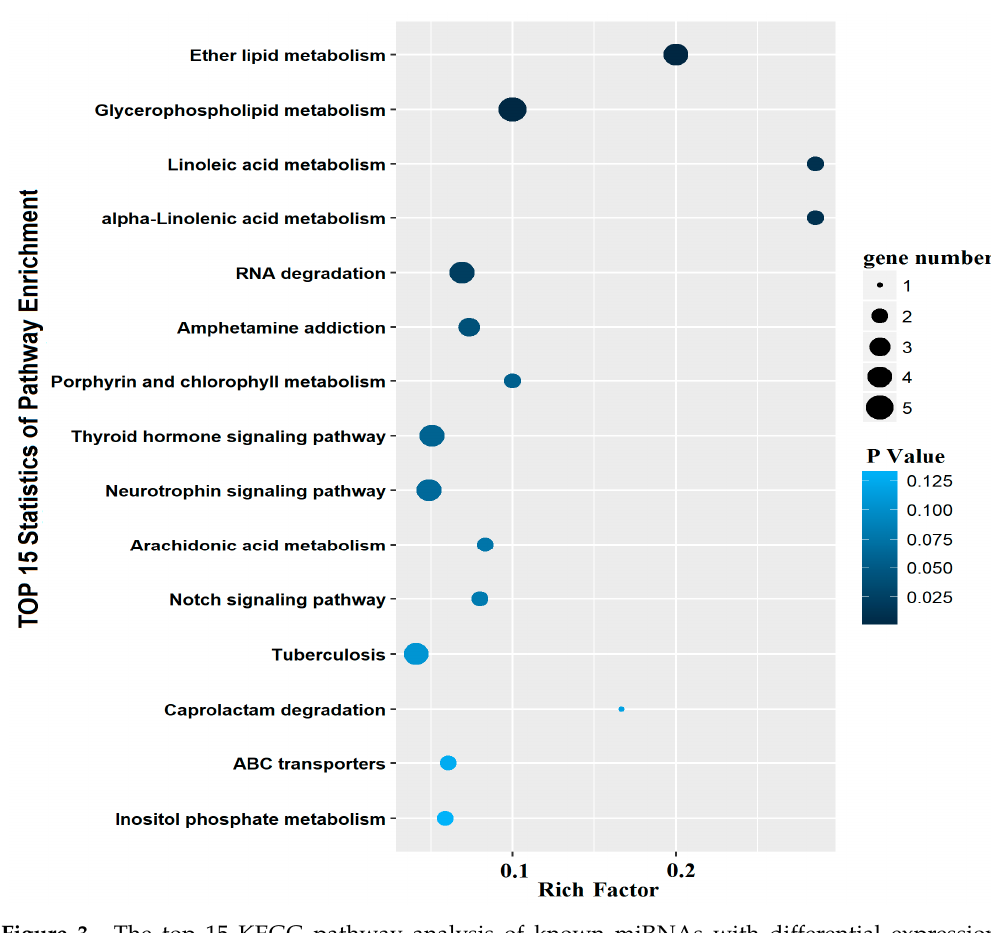
Figure 3. The top 15 KEGG pathway analysis of known miRNAs with differential expression. The horizontal coordinates was the rich factor. The bigger the rich factor the higher the enrichment.